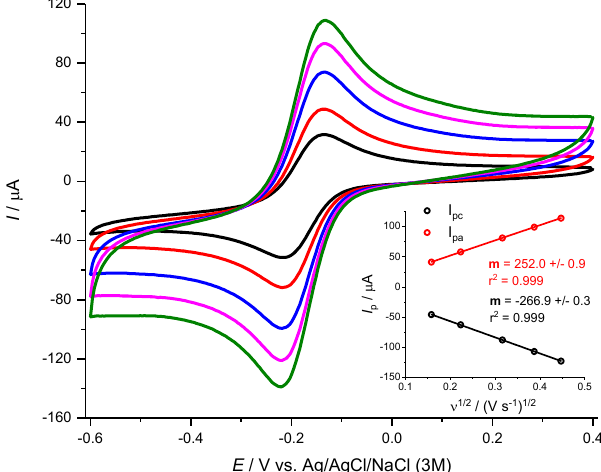
Figure 3. Reversible redox reaction of Ru(III)(NH 3 ) 6 in 0.5 M KCl at increasing scan rates (from 20 mV s − 1 in black to 200 mV s − 1 in green) and respective I p vs. ν 1/2 plot for determination of the electrochemical surface area of the depth electrode recording site.